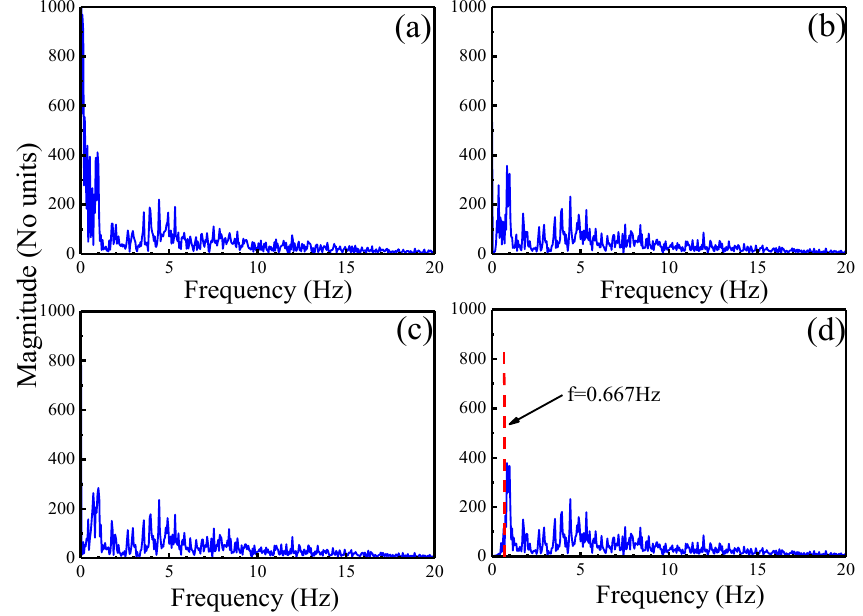
Sensors 2019 , 19 , x FOR PEER REVIEW Figure 8. The frequency domain diagram of the denoised signals for real ECG signals using various motion artifact removal methods. ( a ) Original ECG signal; ( b ) DWT; ( c ) EMD; ( d ) EWT-WT.